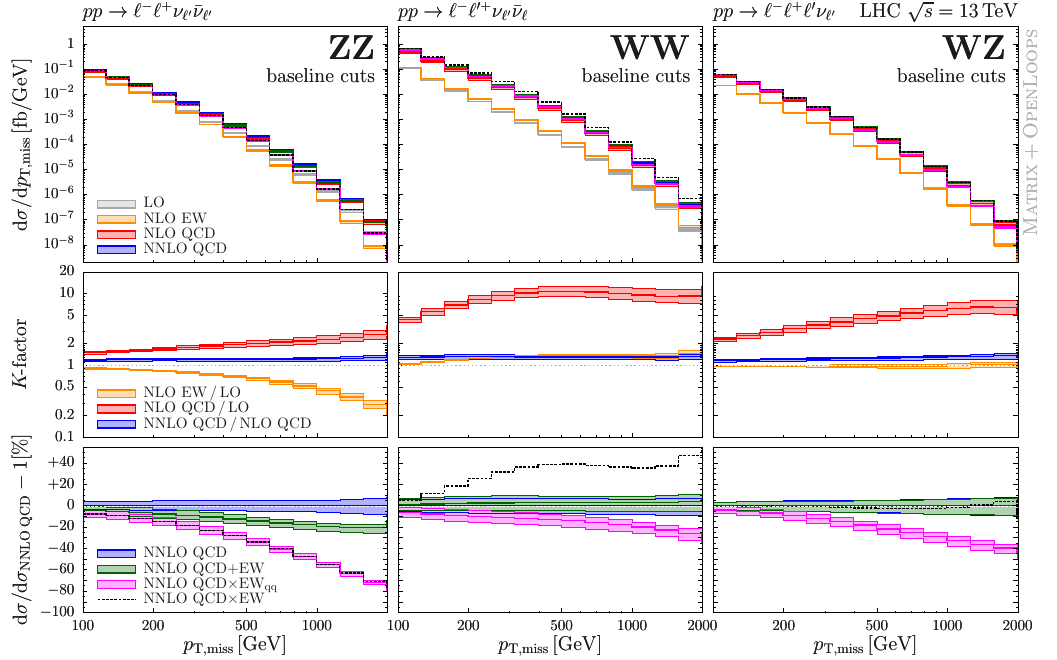
Figure 10 . Distribution in the missing transverse momentum (calculated from the vectorial sum of the neutrino momenta) for the processes (3.1){(3.3) at 13 TeV. Baseline cuts are applied without jet veto. Plot format and predictions as in (cid:12)gure